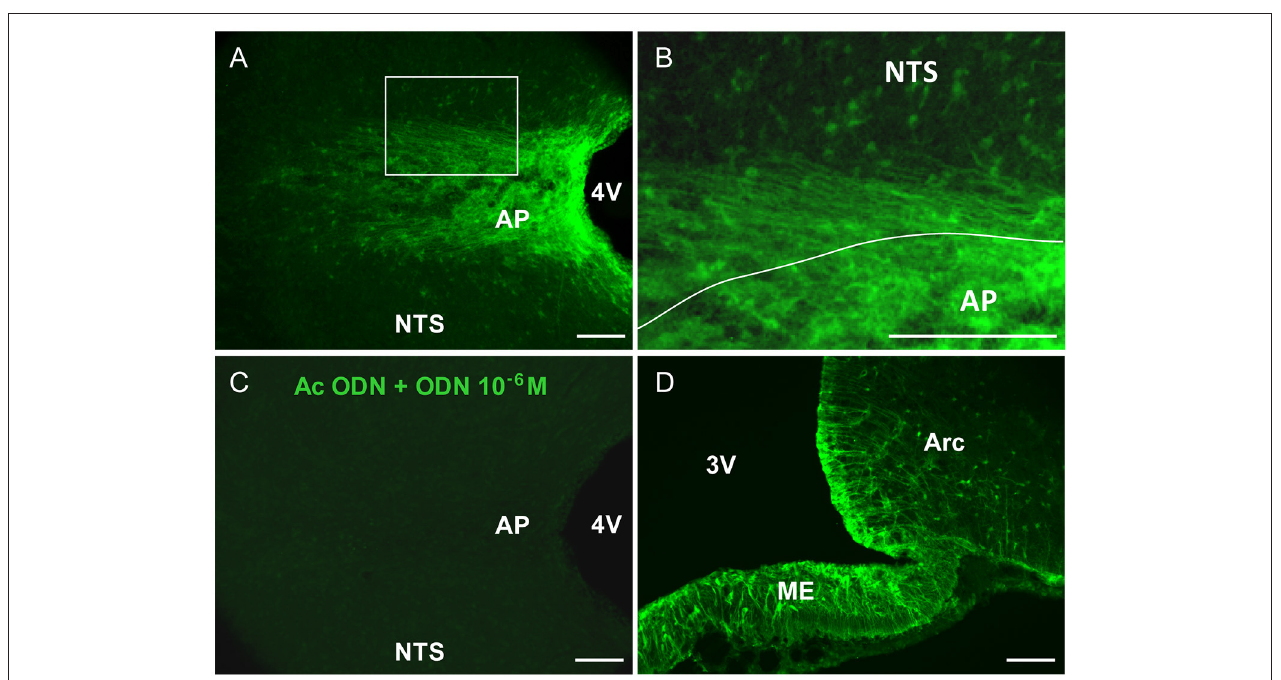
FIGURE 1 | ODN immunohistochemistry in the brainstem. (A) Confocal fluorescent micrographs illustrating ODN immunohistochemistry performed on horizontal brainstem sections. ODN immunostaining showed the presence of positive cells in the area postrema (AP), at the border between AP and nucleus tractus solitarius (NTS) and within NTS surrounding the AP. Lateral dorsal vagal complex was devoid of labeling. (B) High magnification microphotograph originating from image in A (rectangle in A) and illustrating the shape of ODN immunoreactivity within the AP and surrounding structures. (C) Pre-incubation of ODN antibody with an excess of ODN peptide resulted in the absence of staining. (D) Confocal fluorescent micrograph illustrating ODN immunohistochemistry performed on coronal hypothalamic sections. As expected ODN immunoreactivity was found in the median eminence (ME), tanycytes lining the 3th ventricle (3V) and arcuate nucleus (Arc). 4V, 4th ventricle. Scale bars: 100 µ